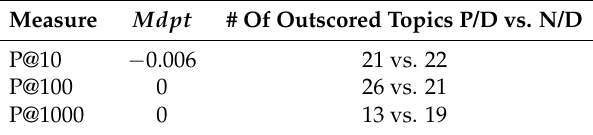
Table 16. T2: mdpt of P/D vs. N/D and count of the number of topics in which P/D is better than N/D and